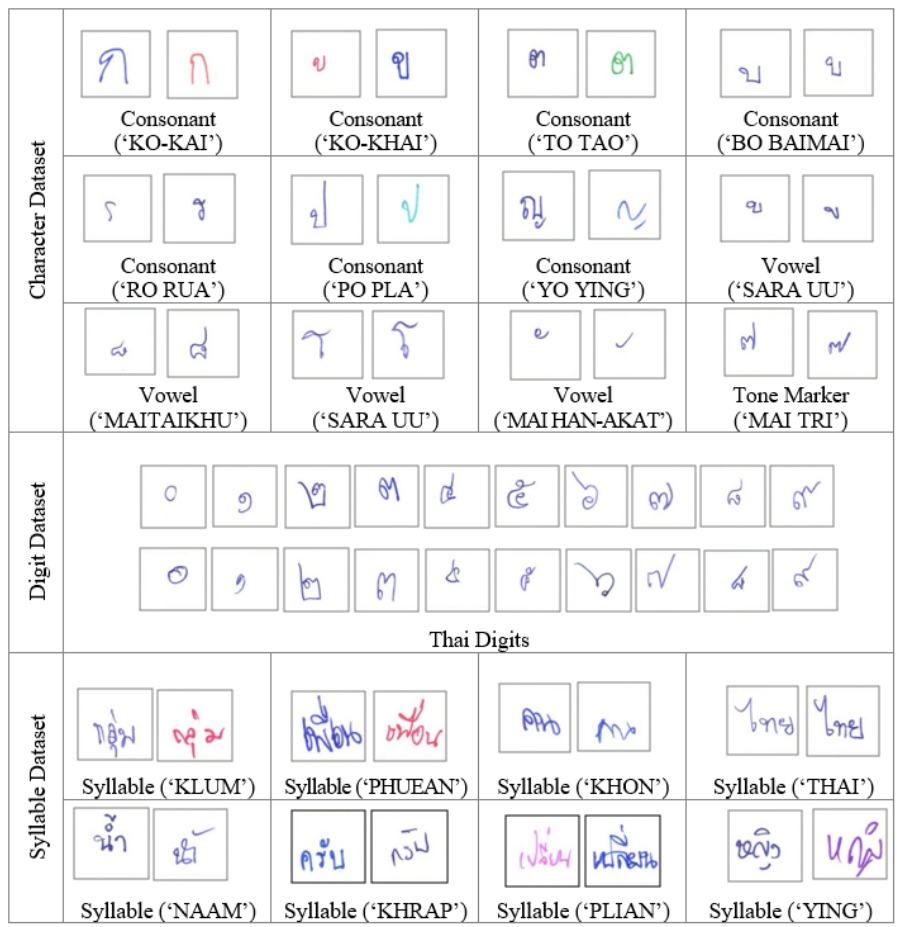
Figure 7. Examples of handwriting styles included in Burapha-TH.